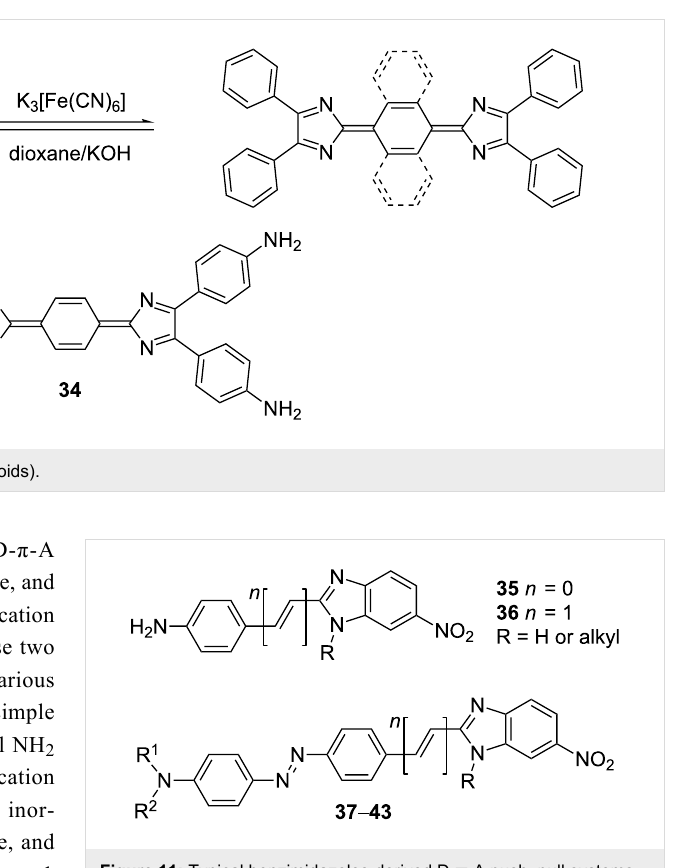
Figure 11: Typical benzimidazoles-derived D- π -A push–pull systems 35 – 43